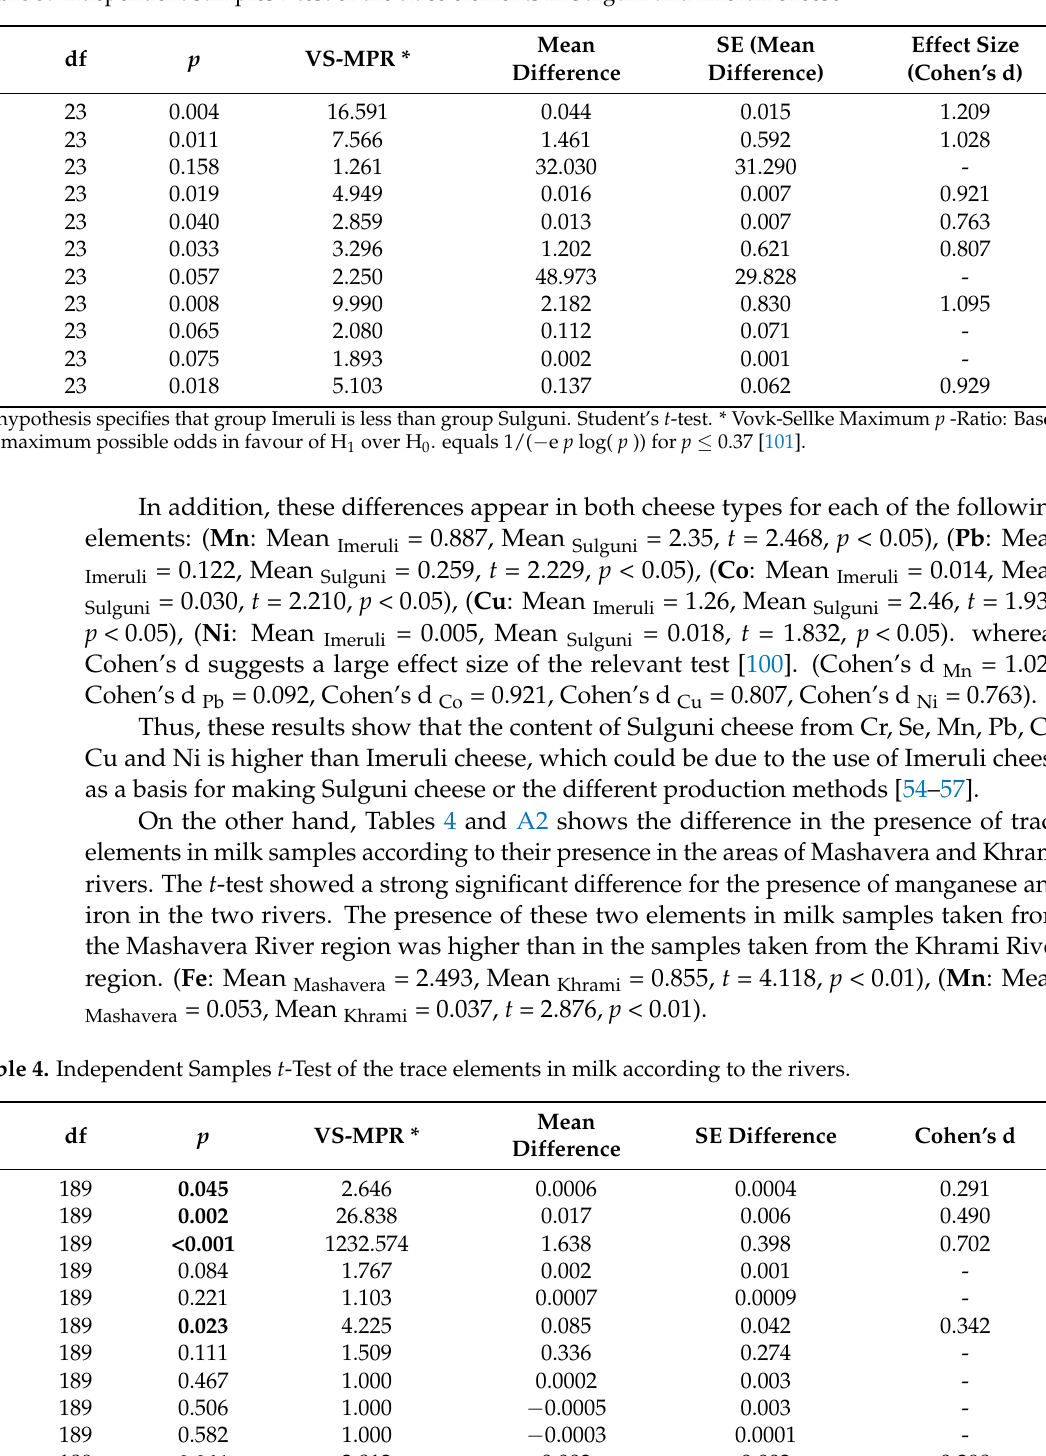
Table 4. Independent Samples t -Test of the trace elements in milk according to the